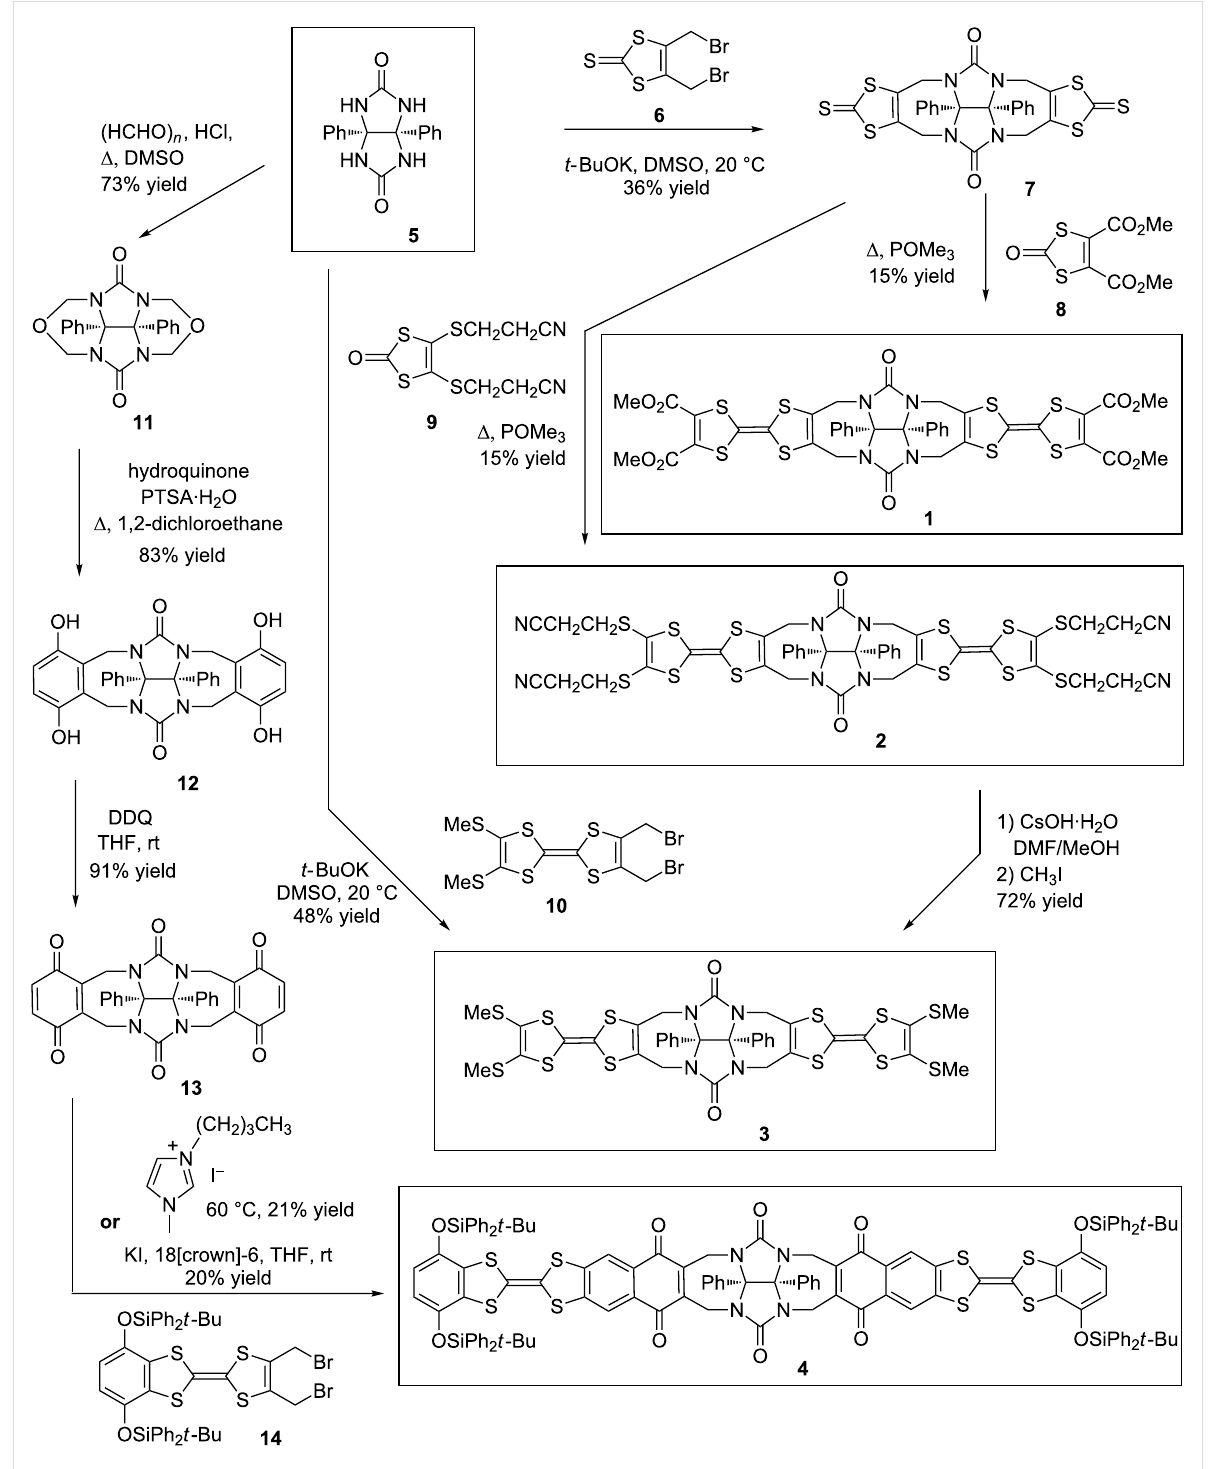
Scheme 1: Different routes developed for the synthesis of molecular clips 1–4 .